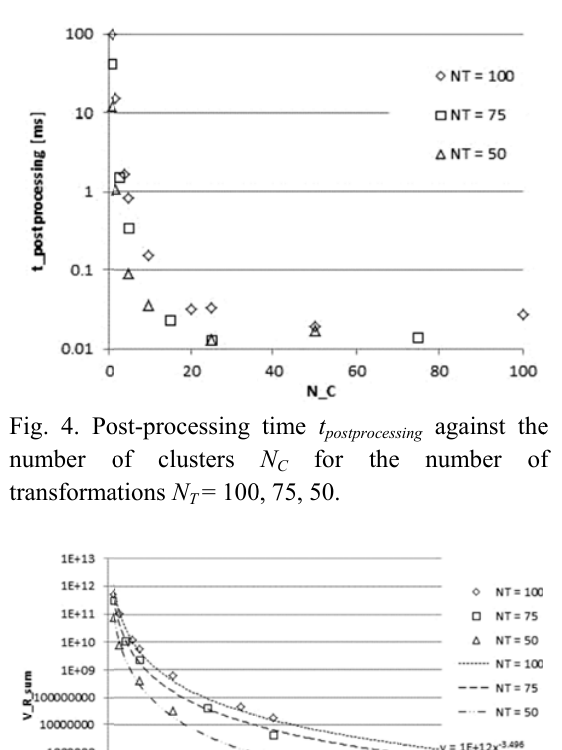
lues except for